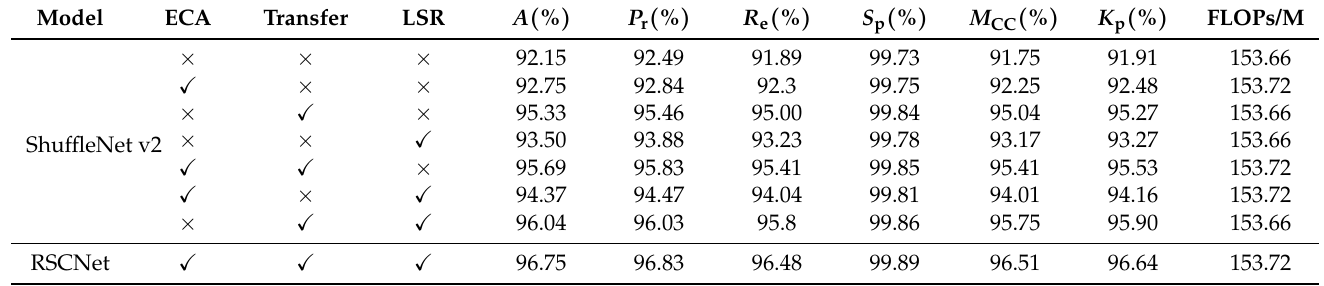
Table 4. Test results of the proposed method on the AID dataset. The training data ratio is 0.8.